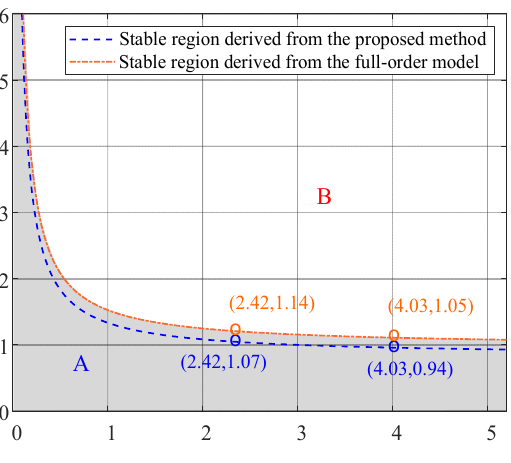
Figure 5. Stable field.